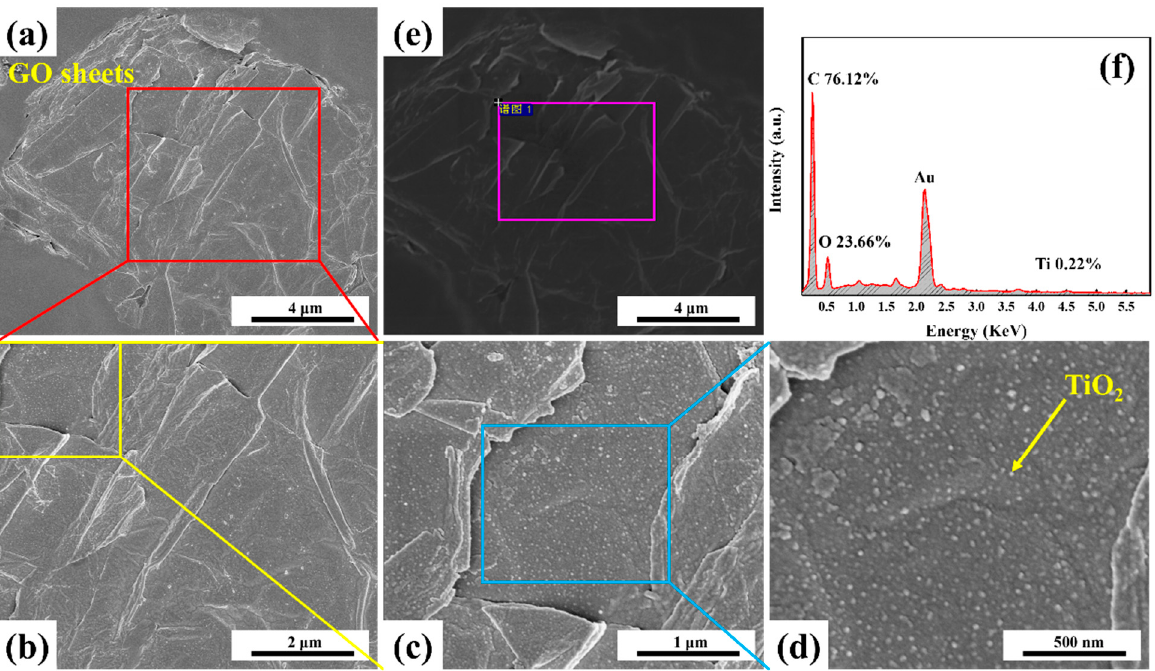
Figure 4. ( a – e ) FESEM images of the GO nanosheets which were isolated from the GO/TiO 2 /PAN membranes. ( f ) corresponding EDX spectrum of the GO surface.